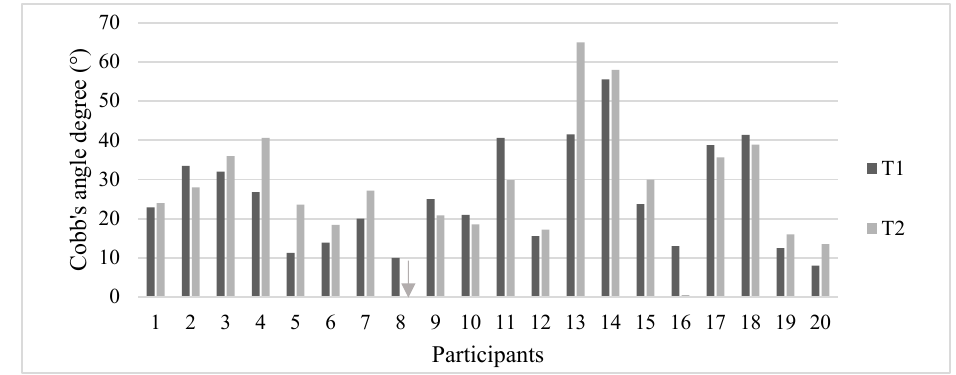
Figure 2. Cobb’s angles of each participant at T1 and T2. Gray arrow (participant no. 8) represents the absence of scoliosis at T2.